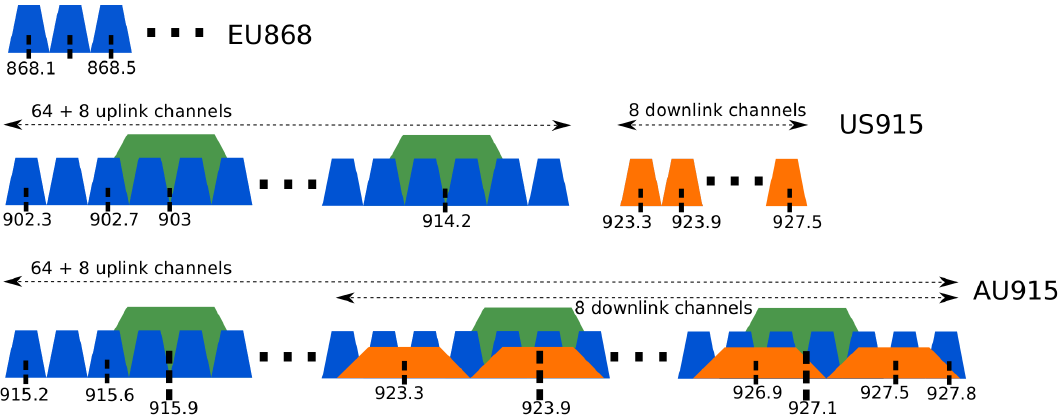
Figure 1. Long Range Wide Area Network (LoRaWAN) channels for Europe, USA, and